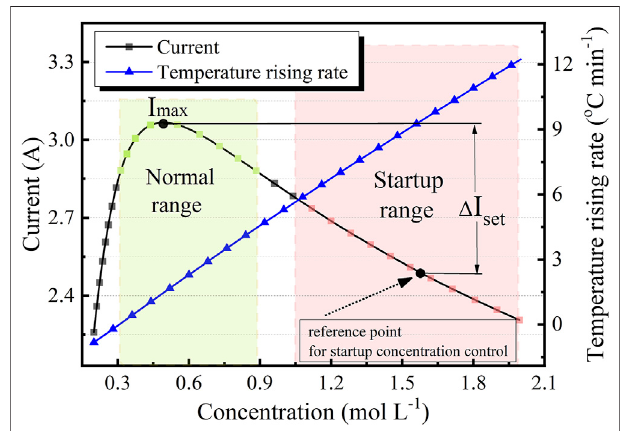
FIGURE 2 | Relationship of the current, temperature rising rate, vs. methanolconcentration ofourtest system. Stack state: 26units ofMEAswith 25 cm 2 active area per unit. Discharge voltage: 0.4 V cell − 1 . Temperature: 60 ° C.Greenarea:concentrationcontrolrangefornormaloperation.Red area: concentration control range for startup